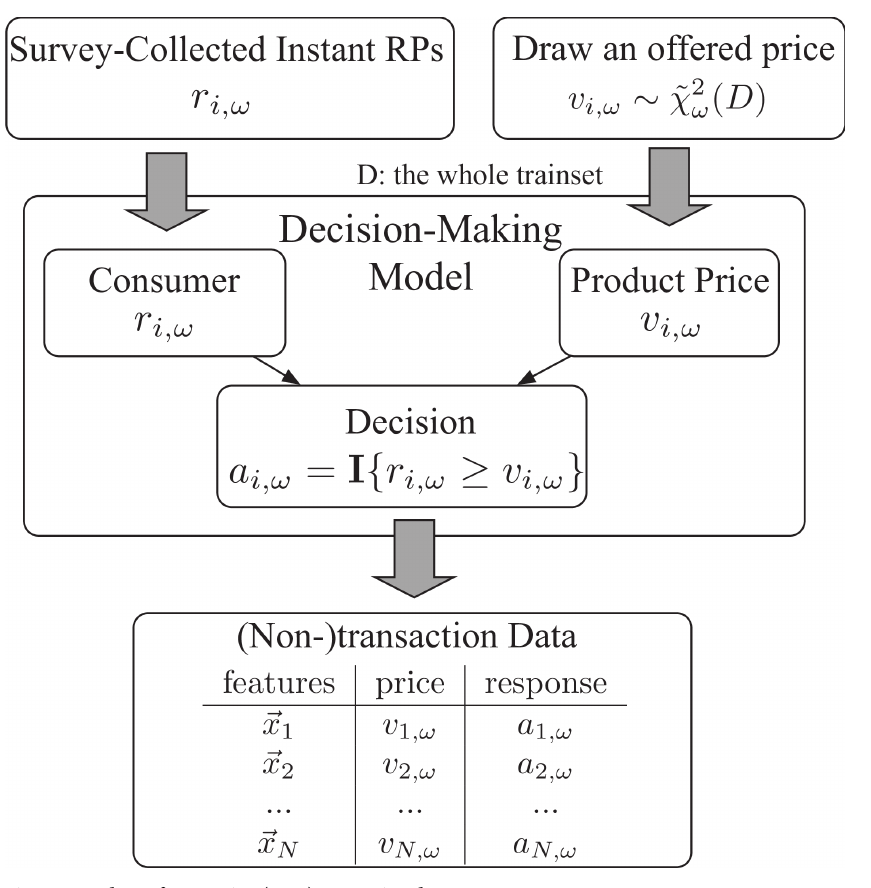
Fig 8. Procedure of generating (non-)transaction